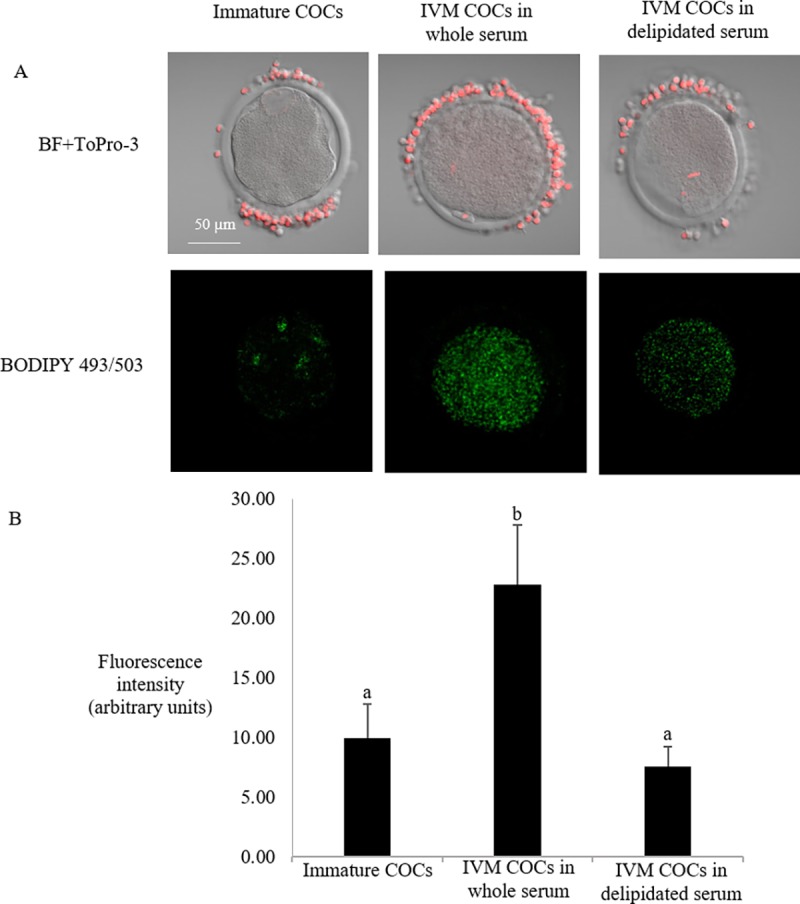
Lipid quantification of partially denuded COCs in vitro matured with control whole serum or delipidated serum (Experiment 1).a) Nuclei of cells were stained with ToPro-3 (red) and merged with bright field image (BF). Neutral lipid staining with BODIPY 493/503 (green) show an increase in lipid droplets of oocytes after exposure to IVM media supplemented with control whole serum. b) Comparison of the lipid content of immature (Immature, n = 23) and COCs in vitro matured in a medium supplemented with control whole (n = 24) or delipidated (n = 24) estrous sheep serum. Values are expressed as average of BODIPY fluorescence intensity in the ooplasma per area ± SEM. a vs b indicates significant differences (P<0.05).